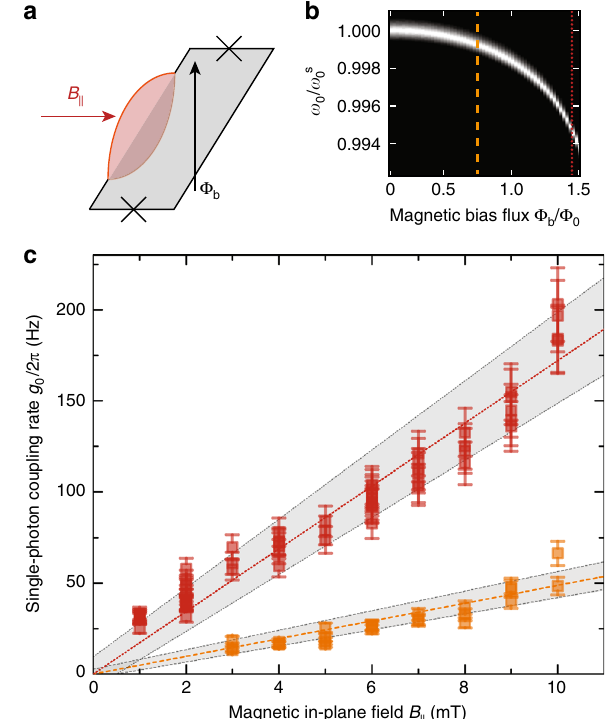
Fig. 4 Scaling up the optomechanical single-photon coupling rate with the applied in-plane magnetic fi eld. a Representation of the applied magnetic fi eld components to the SQUID loop. During the experiment, the cavity fl ux responsivity was fi xed at two different values by adjusting the fl ux bias point Φ . In addition to this constant parameter, the in-plane magnetic fi eld b j B jj was swept from 1 to 10 mT in steps of 1 mT. The transmission j S 21 depending on the normalized bias fl ux is shown in ( b ) for B jj ¼ 1 mT (black: 0 dB, white: (cid:4) 30 dB). The two different set-points represented as orange jj is set dashed and red dotted lines, respectively, correspond to a fl ux responsivity of (cid:5) 17 MHz = Φ and (cid:5) 60 MHz = Φ . Posterior to tuning the cavity to the 0 0 desired working point, an OMIT experiment was performed and the single- photon coupling rate of the system was extracted. The experimental procedure was repeated in increasing steps of 1 mT of in-plane fi eld. The resulting single-photon coupling rates g are shown in ( c ) as squares. The 0 dashed and dotted lines show theoretical lines and the gray areas consider uncertainties in the fl ux responsivity of 10 % and a possible in-plane fi eld offset of ± 0 : 5 mT. Error bars consider 10 % uncertainty in the extracted values, cf. Supplementary Note